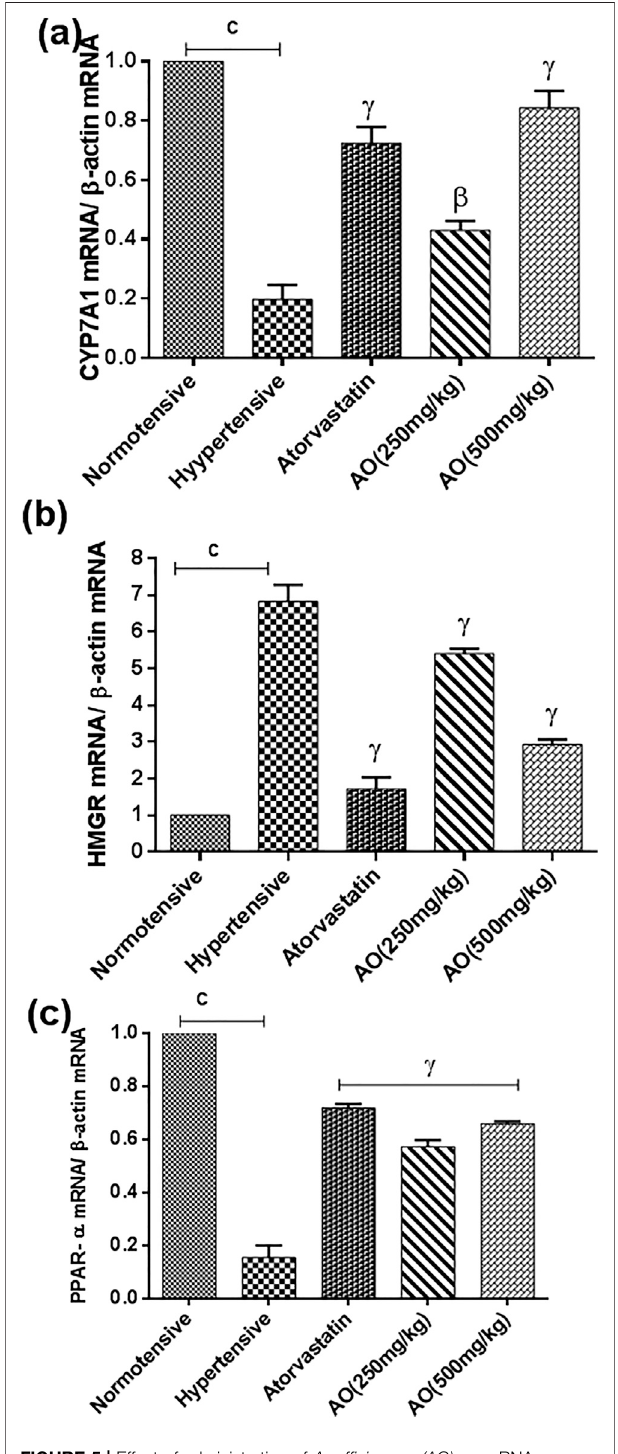
FIGURE 5 | Effect of administration of A. of fi cinarum (AO) on mRNA expression of (A) 7 α -hydroxylase (CYP7A1), (B) 3-hydroxy-3methyl-glutaryl- coenzyme A reductase (HMGR), and (C) peroxisome receiver activator alpha (PPAR- α )performedbyqRT-PCRintheliverofchronic obesogenic diet- fed hypertensive rats. The results are stated as means ± S.E.M ( n (cid:1) 6), where a (cid:1) p < 0.05, b (cid:1) p < 0.01, and c (cid:1) p < 0.001 vs normotensive rats. α (cid:1) p < 0.05, β (cid:1) p < 0.01, and ɣ (cid:1) p < 0.001 vs hypertensive rats.